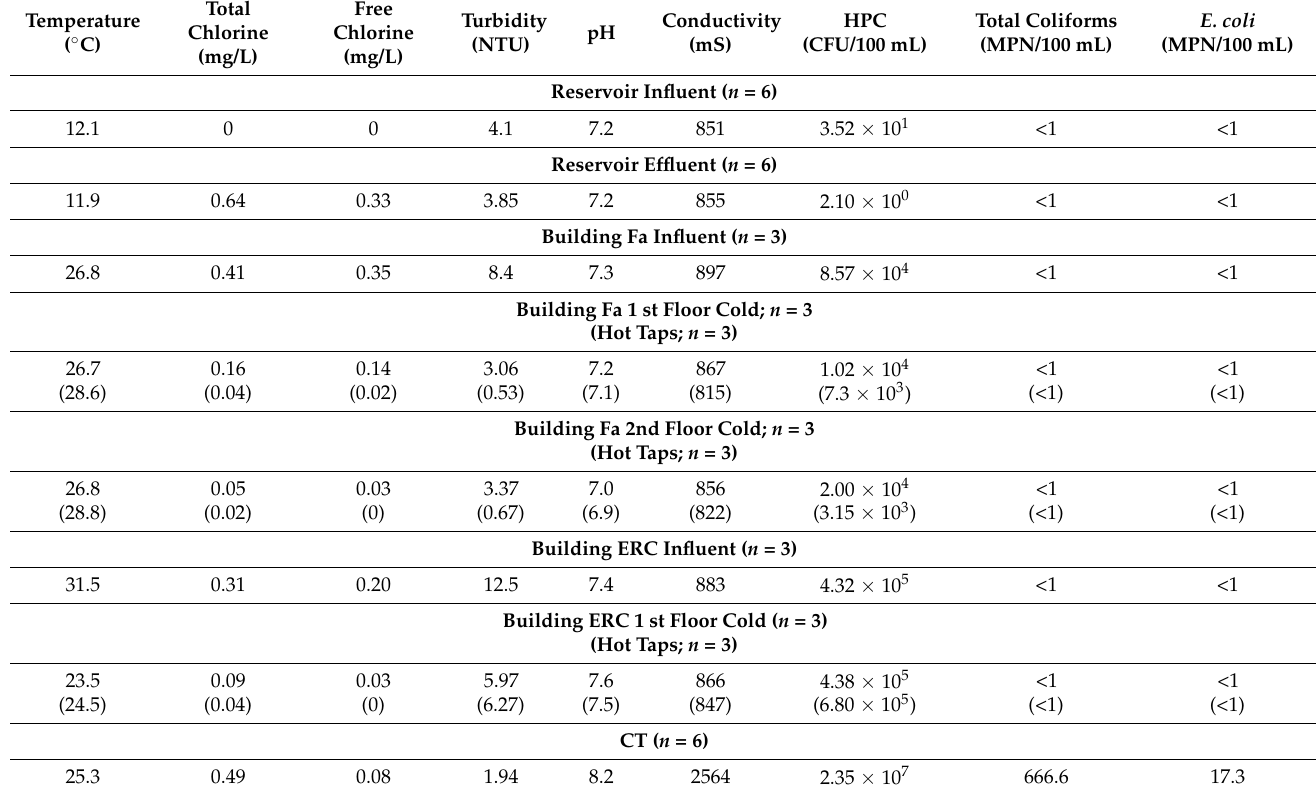
Table 4. Water quality parameters of the reservoir (influent and effluent), the influent, hot- and cold-water (all three sample types were collected on the same day, but replicates were collected on different days) in buildings (Fa and ERC), and the CT. Sample collection dates are as follows: reservoir (influent and effluent), 15, 23 and 29 July and 6, 13 and 20 August; influent, hot-, and cold-water in building Fa, 12 August and 3, 16 September; influent, hot-, and cold-water in building ERC, 19 August, and 9, 23 September; CT, 25, 31 July and 7, 14 and 21 August; two cooling tower water samples were collected on the 21st.